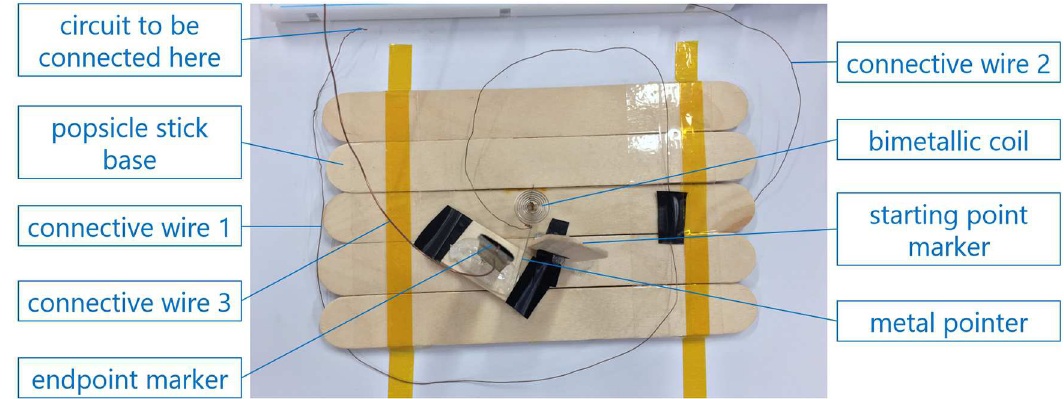
Fig. 2. A part of the top view of the bimetallic ammeter. It shows the various components on the popsicle stick base. To clarify, a part of connective wire 2 is located underneath the popsicle stick base and is connected to the fixed end of the coil. Note that the connective wires 2 and 3 are linked to parts in Figure